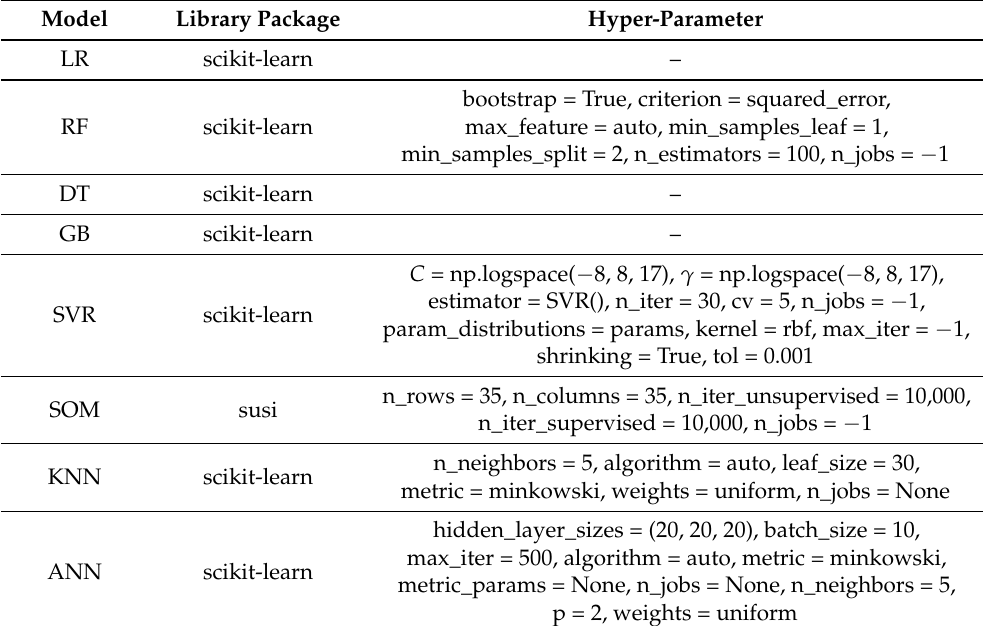
Table 1. Hyperparameter setup for different machine learning regression models.